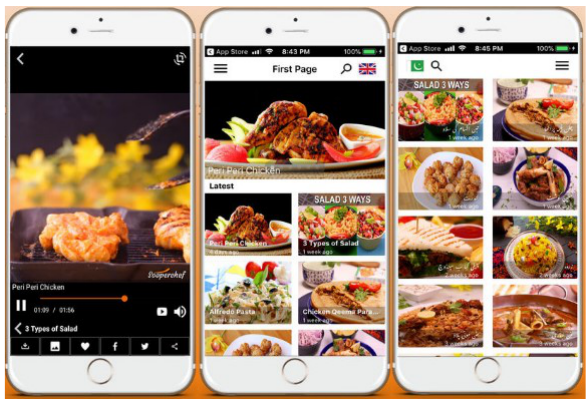
Figure 1. Cook Rice Online